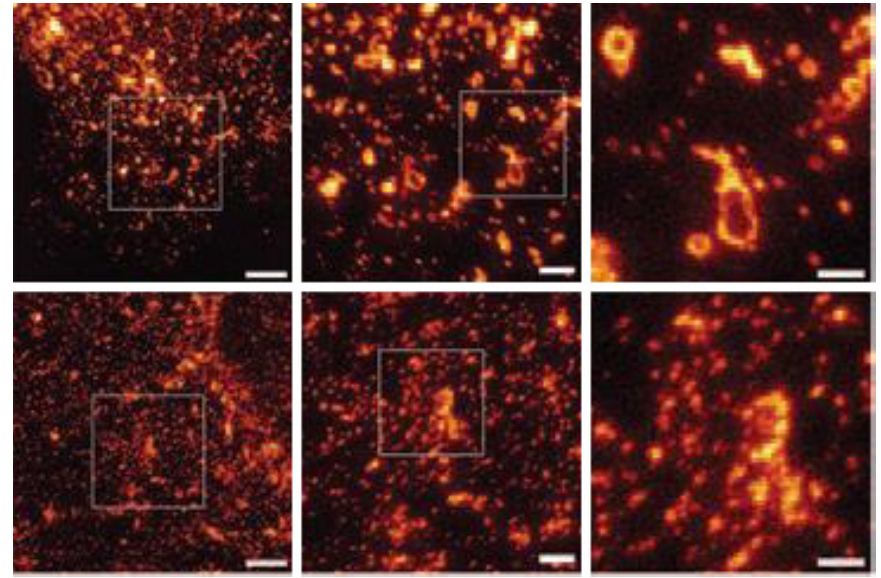
Fig. 3. STED images of cells stained with the transferrin receptor (TfnR) aptamer c2 (top) or with a monoclonal TfnR antibody (bottom). Scale bars are 3 (cid:1) m in left, 1 (cid:1) m in middle, and 500 nm in right, respectively. Adapted with permission from Ref.